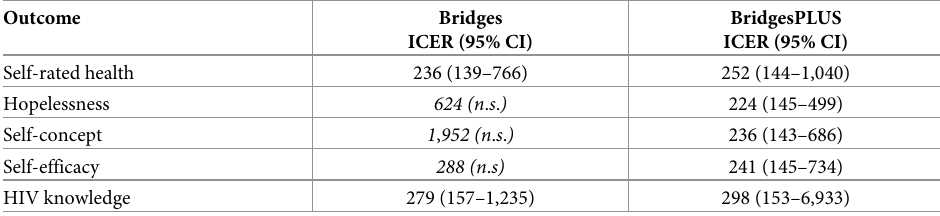
Table 3. Incremental cost-effectiveness ratios (ICER) relative to usual care (in 2012 US dollars).